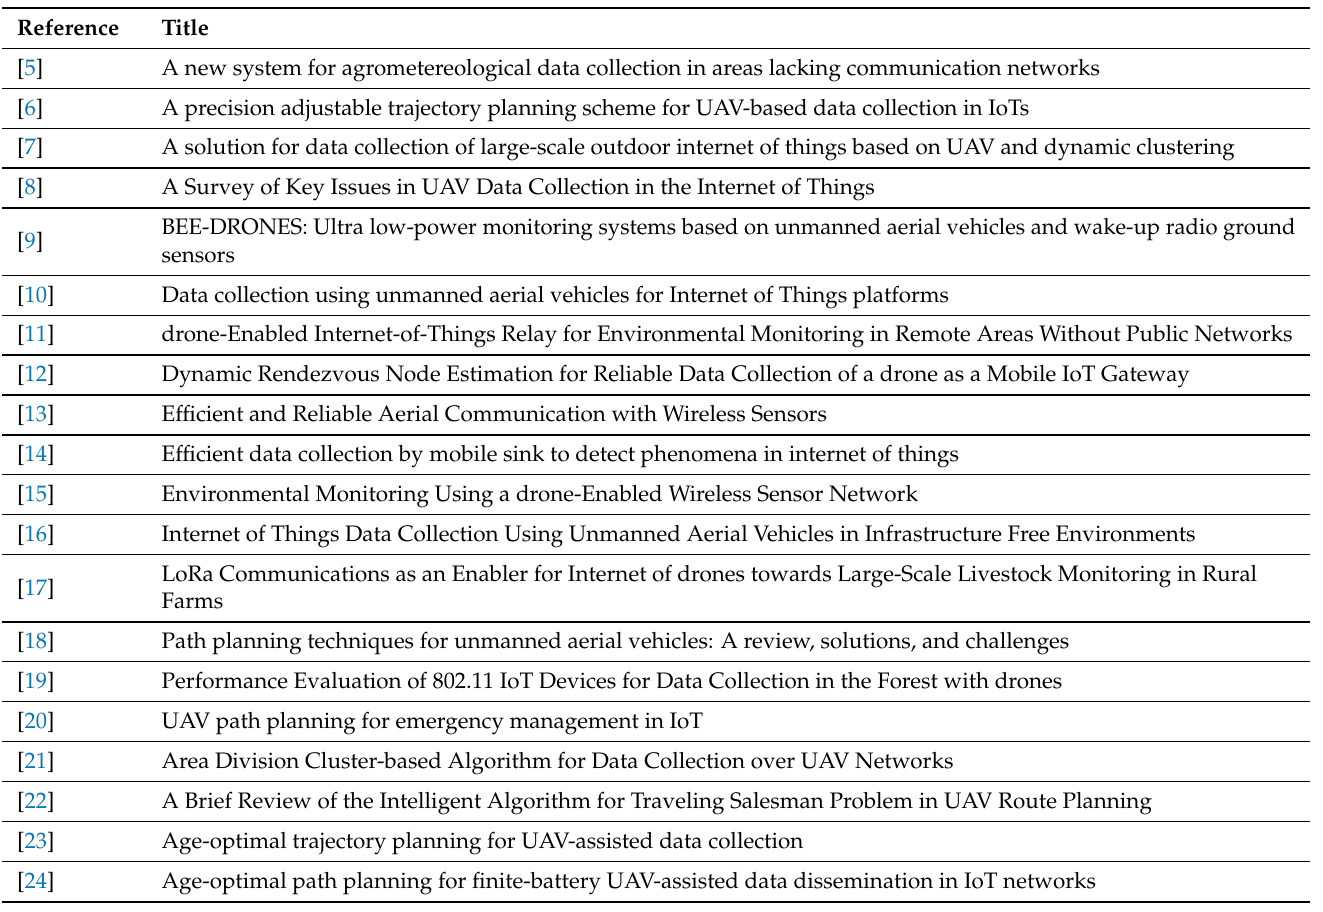
Table 3. Selected papers.